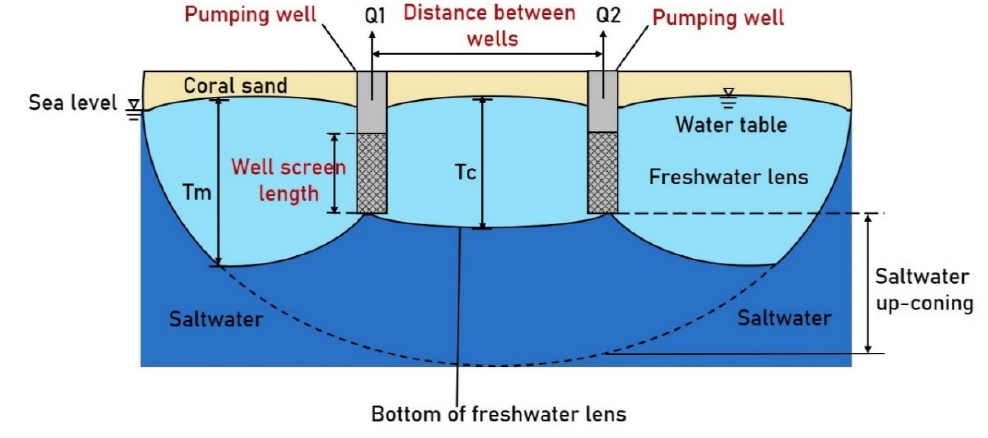
Table 5. Factor-level table of well layout plan (3 factors and 3 levels).